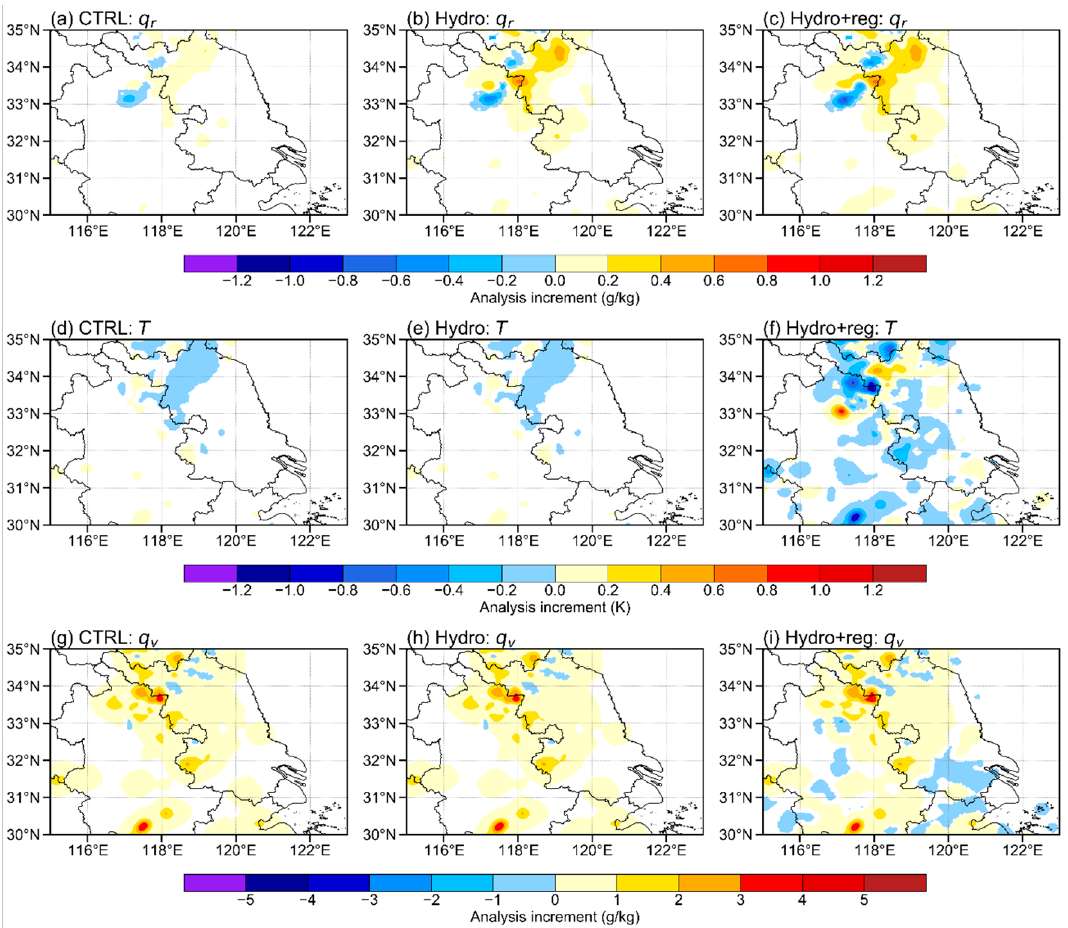
Figure 9. Analysis increment at level 16 of ( a – c ) 𝑞 (cid:3045) (units: g/kg), ( d – f ) 𝑇 (units: K) and ( g – i ) 𝑞 (cid:3049) (units: g/kg) in CTRL (the left column), Hydro (the center column), and Hydro+reg (the right column) experiments.